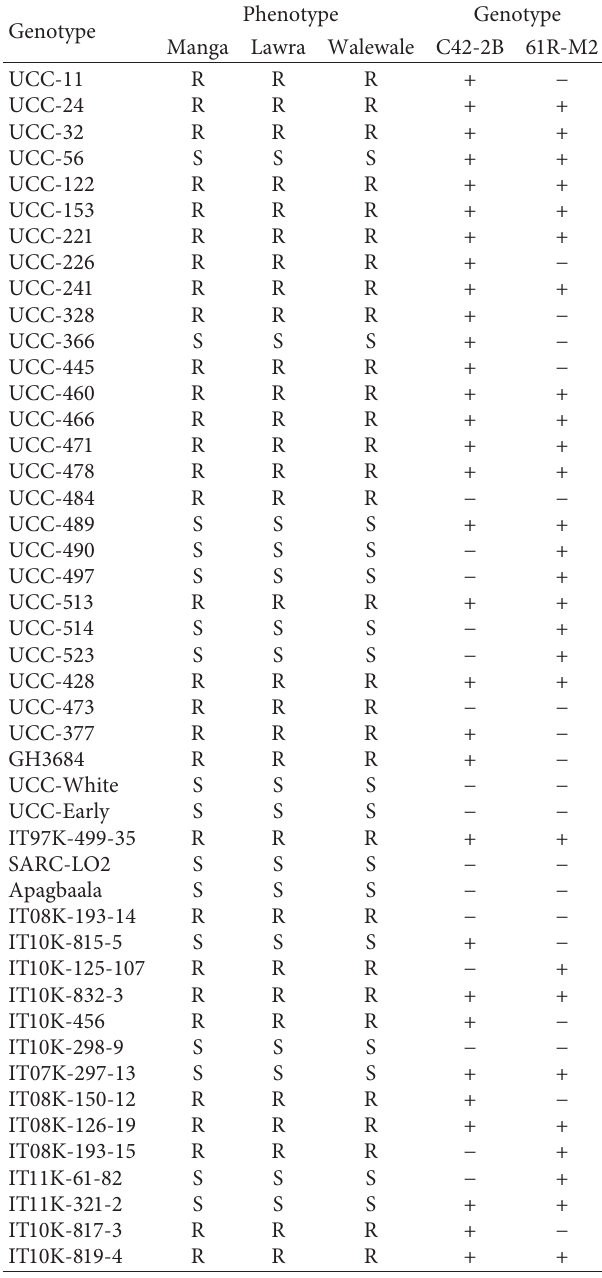
Table 2: The responses of cowpea genotypes to S. gesnerioides